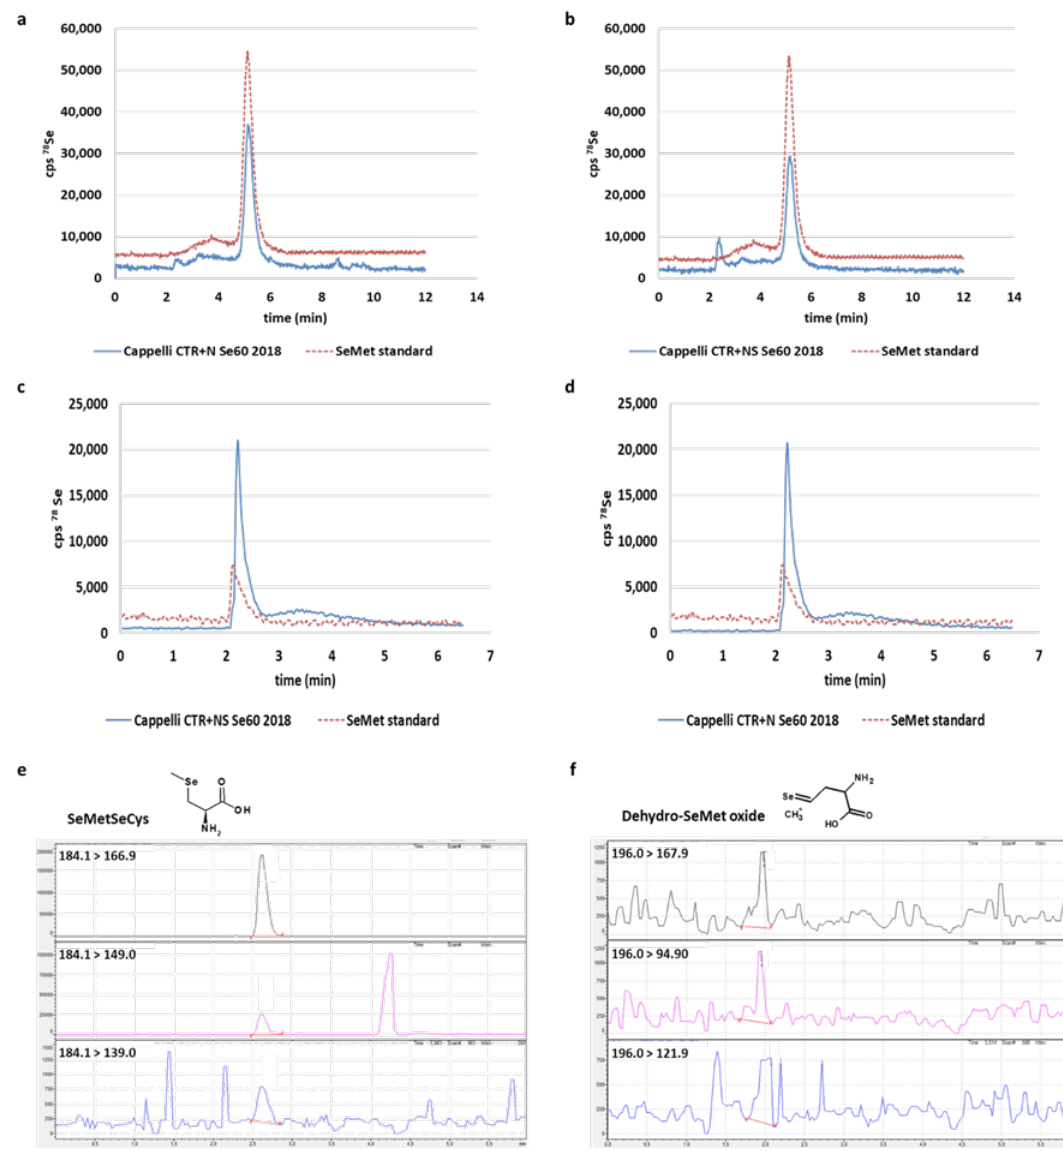
Figure 5. Chromatographic profile obtained by anion-exchange HPLC-ICP-MS from ( a ) Cappelli CTR + N Se60 2018 and ( b ) Cappelli CTR + NS Se60 2018. Chromatographic profile obtained by reverse phase HPLC-ICP-MS from ( c ) Cappelli CTR + N Se60 2018 and ( d ) Cappelli CTR + NS Se60 2018. In the chromatograms, the discontinuous lines correspond to a SeMet standard containing 50 µ g L − 1 . HPLC-ESI-MS/MS analysis to confirm the presence of ( e ) SeMetSeCys and ( f ) dehydro-SeMet oxide in the Cappelli